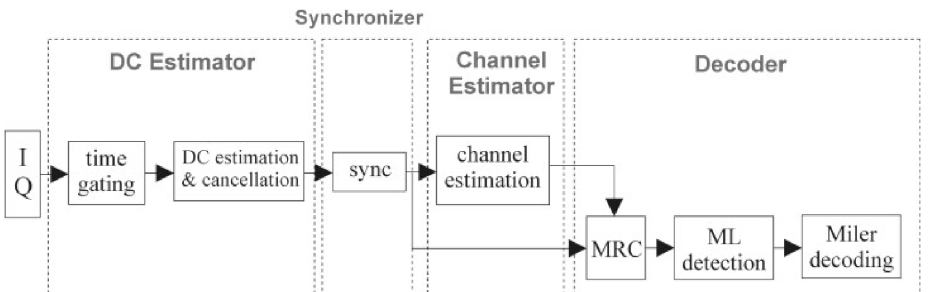
Figure 5. Baseband signal processing architecture